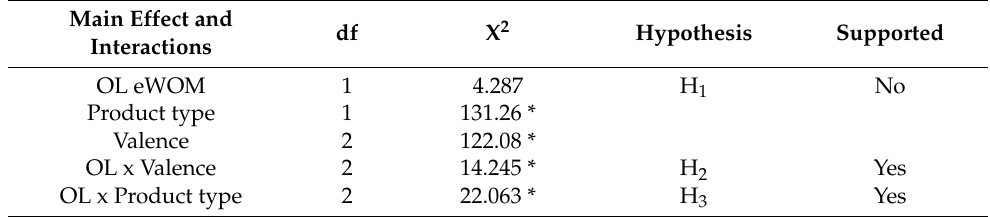
Table 4. Factor Analysis of Variance (FANOVA) for Mixed Effect and Hypotheses testing.